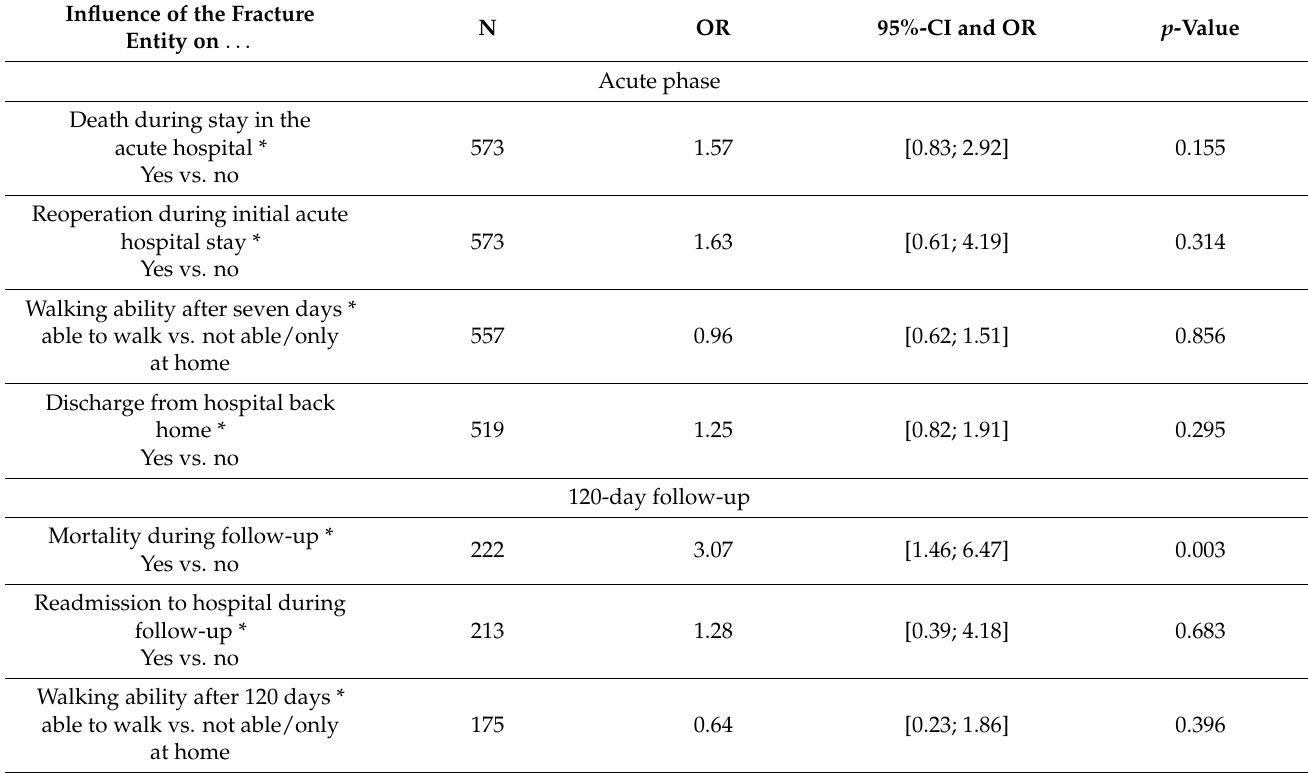
Table 3. Multivariable logistic regression analysis—pathologic vs. non-pathologic femur fracture. Analysis is adjusted for sex, patient age, ASA score, fracture type and pre-fracture walking ability. The model “discharge from hospital” is adjusted to the pre-fracture living